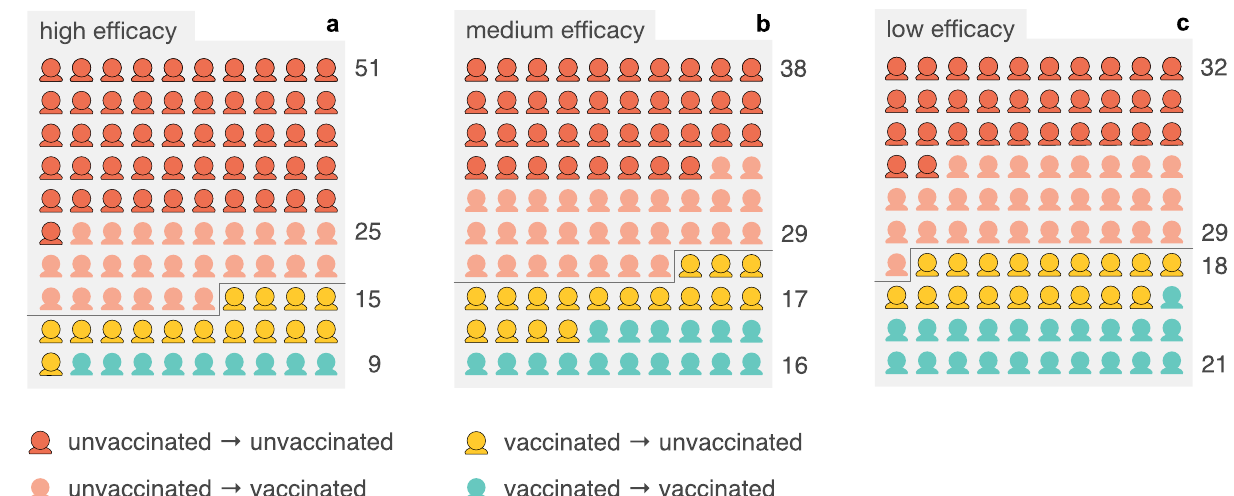
Fig. 1 Estimated contributions of infection pathways towards new cases within vaccinated and unvaccinated subpopulations. Estimated contributions of infection pathways to R in the ( a ) “ high ef fi cacy ” , ( b ) “ medium ef fi cacy ” , and ( c ) “ low ef fi cacy ” scenarios as a graphical representation of Tabs. 2 – 4. The charts can be read as follows: Consider an infected population that caused a new generation of 100 new infecteds. Then for ( a ), 51 of those newly infected individuals will be unvaccinated people that have been infected by other unvaccinated people. Likewise, 25 newly infected individuals will be vaccinated people that have been infected by unvaccinated individuals. Hence, 76 new infections will have been caused by the unvaccinated. Along the same line, 15 newly infecteds will be unvaccinated people that have been infected by vaccinated individuals and 9 newly infecteds will be vaccinated people that have been infected by other vaccinated individuals, totaling 24 new infections that have been caused by vaccinated